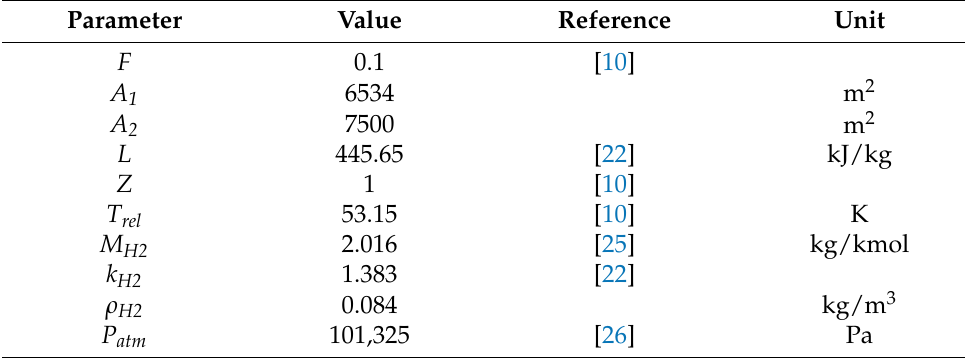
Table 2. Parameters to estimate the minimum required discharge flow rate of hydrogen from each vent